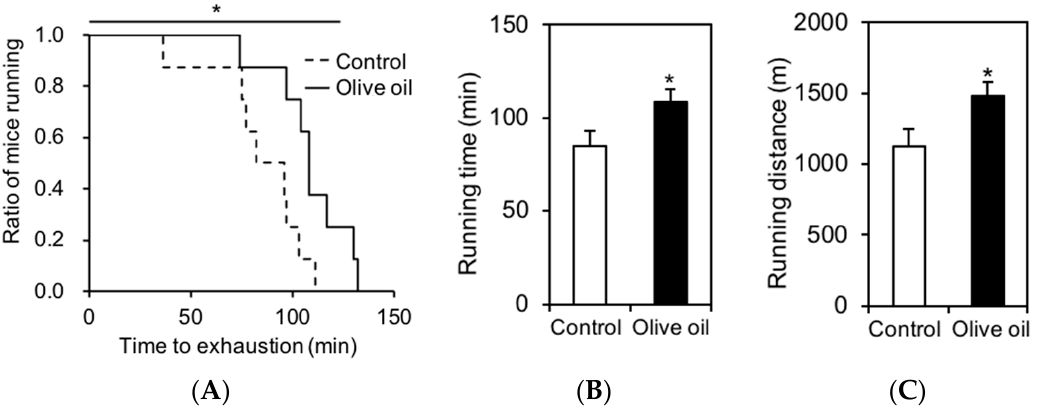
Figure 1. Treadmill running endurance test. ( A ) Running population: ratio of running mice and time. Each data point represents an individual mouse plotted against the time covered by the said mouse at exhaustion. ( B ) Time and ( C ) distance covered until attaining exhaustion under a forced running exercise-to-exhaustion. Results are presented as means ± SE ( n = 8), *, p < 0.05 vs. control group.